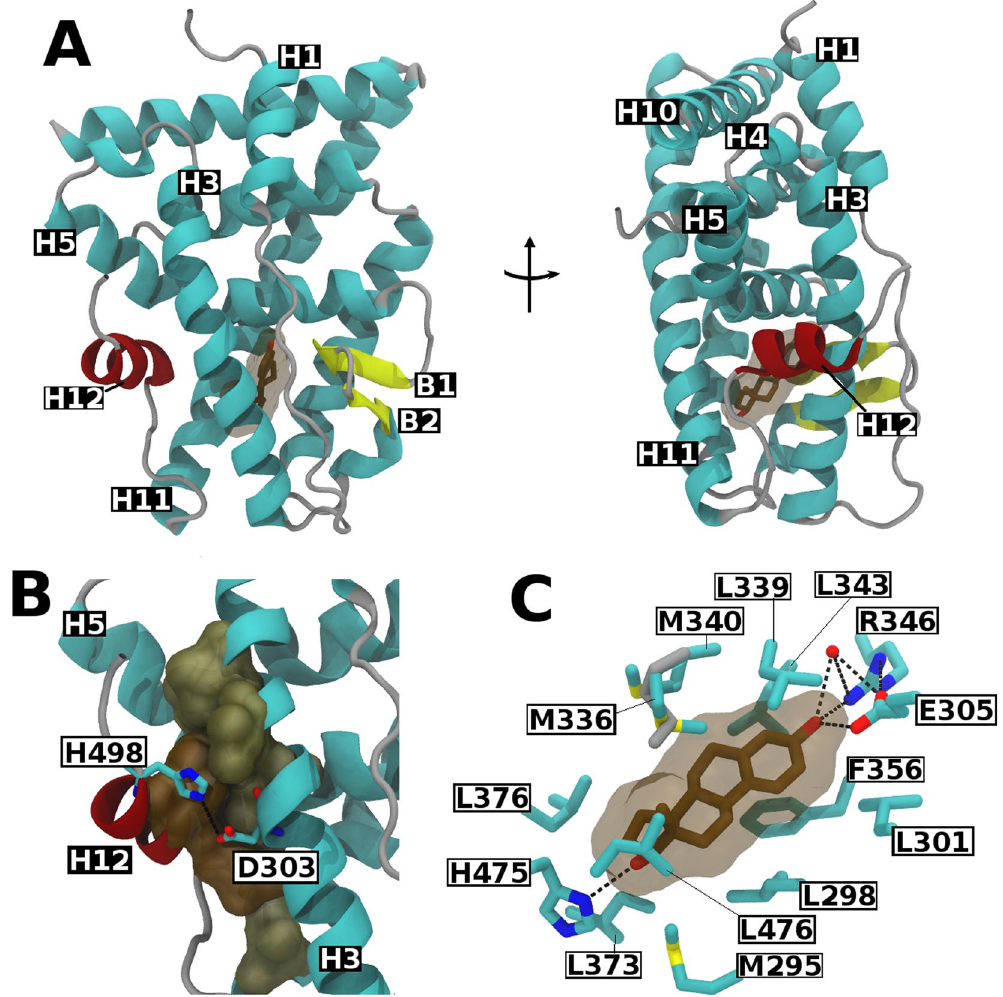
Figure 2. Alternative Structure of the ER β LBD in complex with E2: ( A ) Ribbon representations of the ER β LBD-E2 crystallographic structure indicating the locations of the α -helices (H, cyan), β -sheets ( B ) yellow), coil regions (gray) and E2 (brown surface) in its ligand-binding avity. Helix 12 in its alternative position is highlighted in red. ( B ) Interactions between H12 and the remaining LBD. Hydrophobic contacts are represented as brown surfaces and the hydrophilic interaction D303-H498 as a black dashed line. ( C ) Schematic representation showing E2 (brown) and its interactions with the residues of ER β LBD (cyan). Hydrophilic interactions are represented by black dashed lines. The only observed difference of E2 binding mode of our structure and the already published structures of ER β LBD-E2 (PDB codes 3OLL and 3OLS) is the position of the M336 side chain (highlighted in